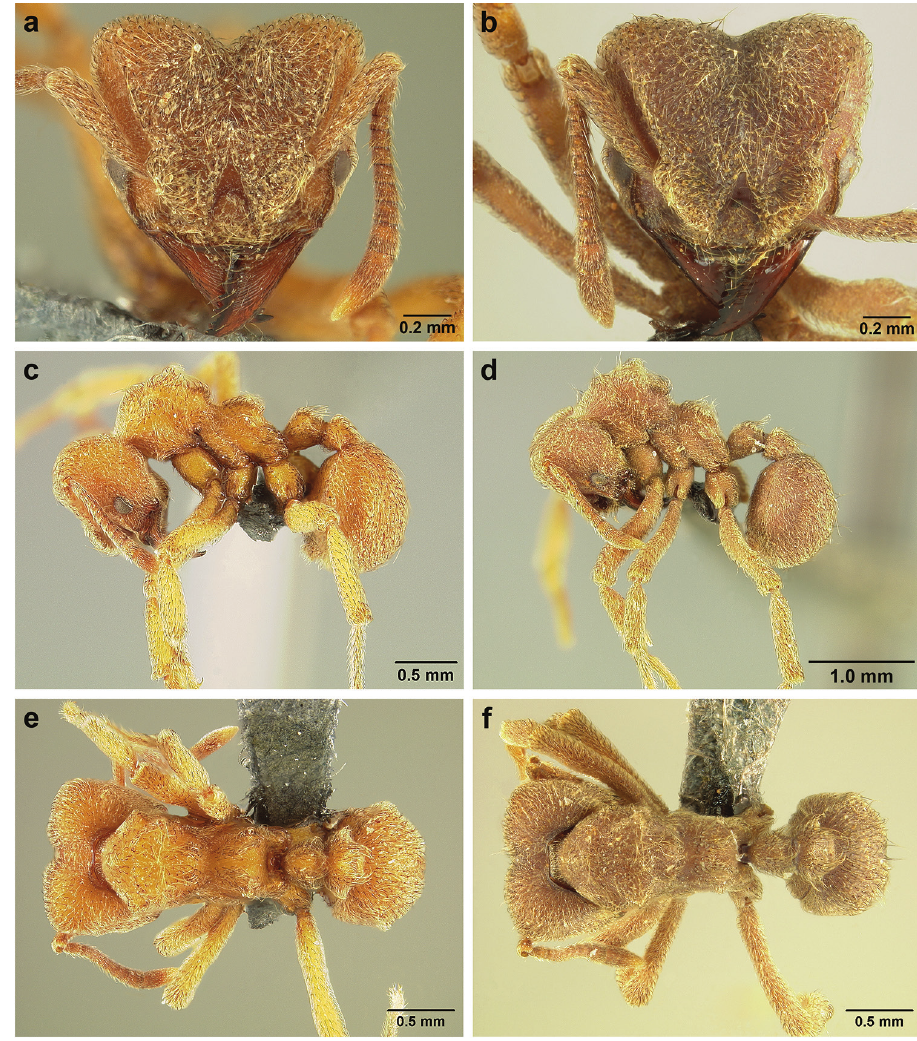
Figure 56. S. saussurei worker; head, profile, and dorsal view. Striate-mandibled form (USN- MENT01125217) ( a, c, e ). Smooth-mandibled form (USNMENT01125221) ( b, d, f ). S. saussurei worker diagnosis. Medium-sized species; mandible usually dorsally striate, frontal carina complete; frontal lobe triangular; eye convex, moderately protruding from sides of head, covered with thick white layer; posterior cephalic emargination abruptly to gradually impressed, mesosomal tubercles from low and obtuse to well developed; first gastral tergite with lateral carinae well developed, dorsal carinae weak to well developed. S. saussurei worker description. Measurements in mm, range (holotype): HWe 0.88–1.23 (0.98) HW 0.88–1.23 (NA) HW1 0.82–1.32 (1) HW2 0.92–1.56 (1.13) HW3 0.55–0.84 (0.7) IFW1 0.59–0.88 (0.67) IFW2 0.19–0.36 (0.24) HL1